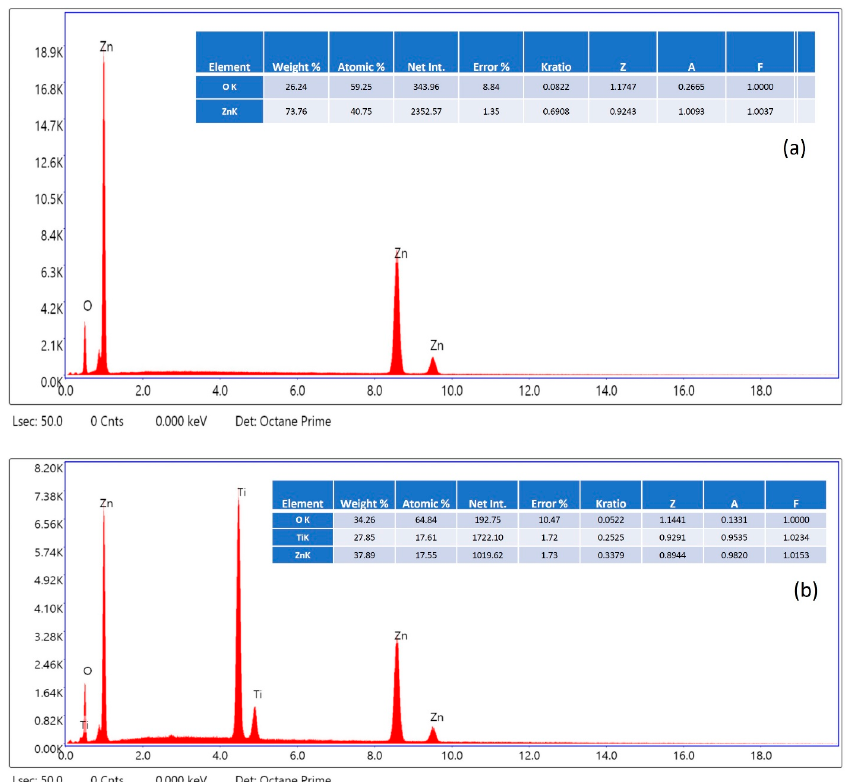
Figure 3. ( a , b ) Pure ZnO and ZnO-doped TiO 2 nanocomposites analyzed by EDAX analysis.